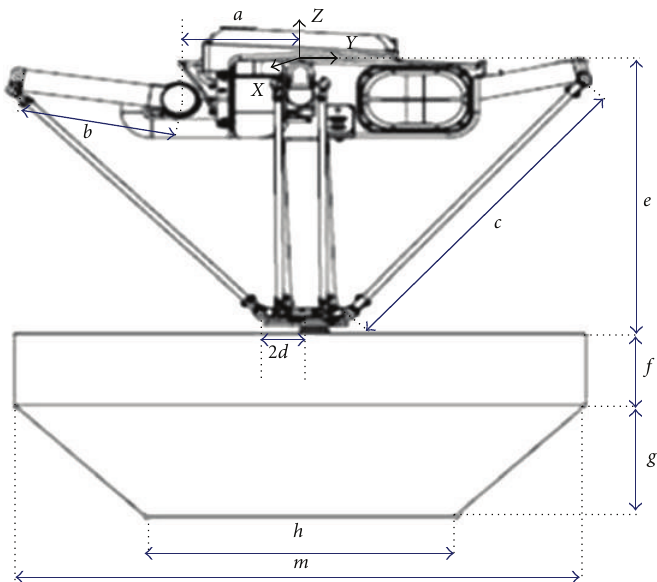
Figure 1: Schematic representation of a 4-RUU parallel robot and of its